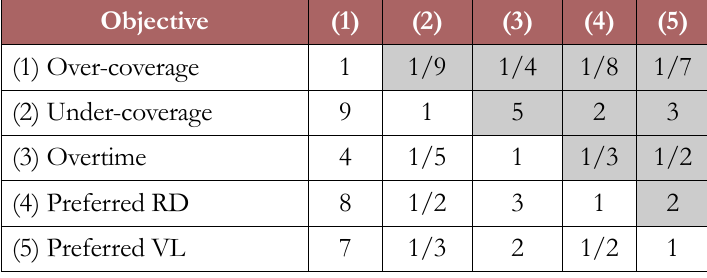
Table 7 . AHP pairwise comparison matrix